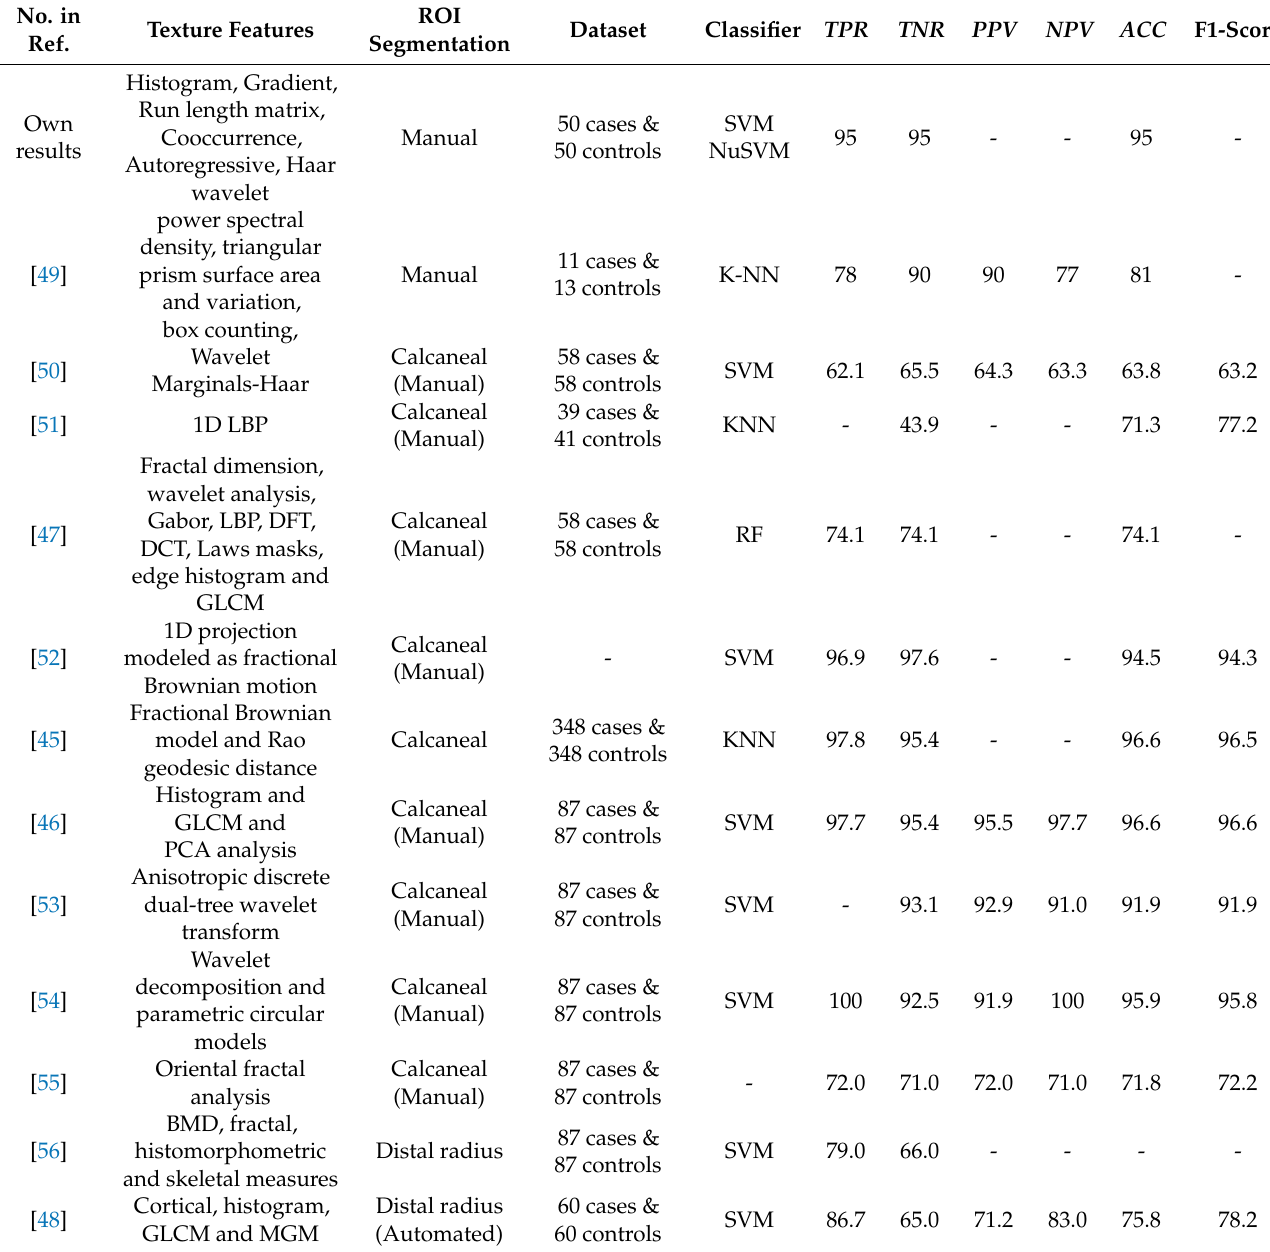
Table 4. Summary of results of similar bone texture analysis tests